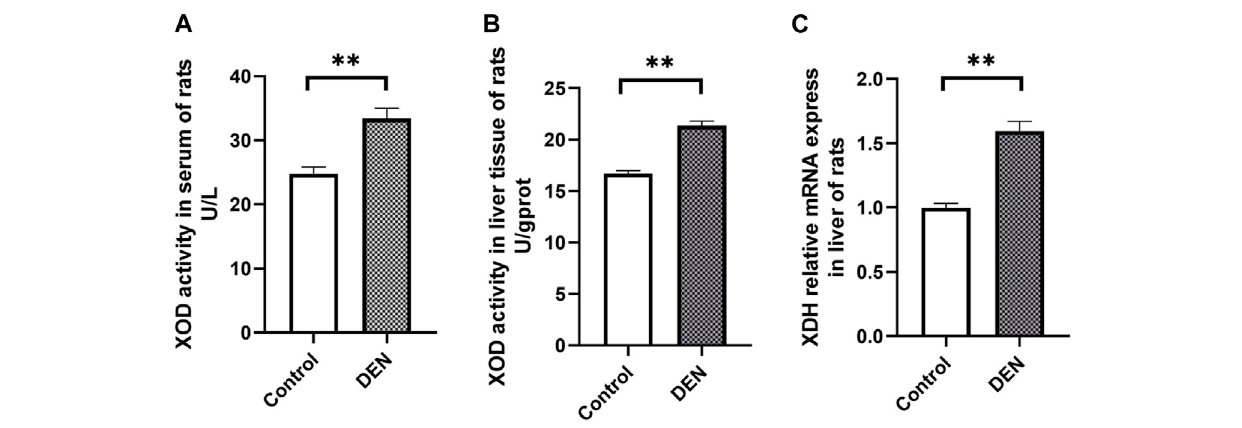
FIGURE 2 | The XOD activity in serum (A) , liver tissues (B) and the XDH mRNA level (C) in liver of healthy (control) and HCC (DEN) rats. **represent signi fi cant differences of DEN group ( n (cid:1) 20, mean ± S.E.M) from the control group ( n (cid:1) 10, mean ± S.E.M, ** p < 0.01).